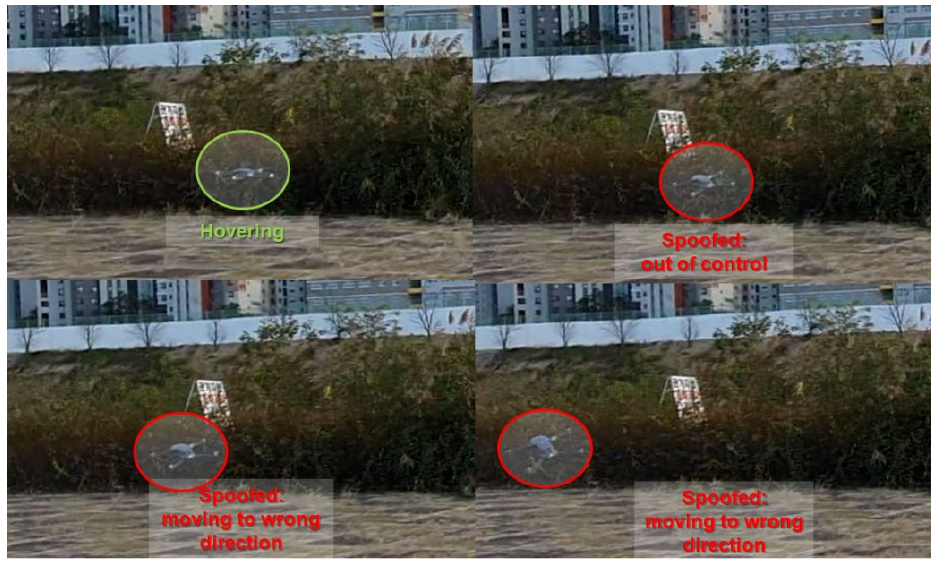
Figure 9. Test result of Mavic drone.